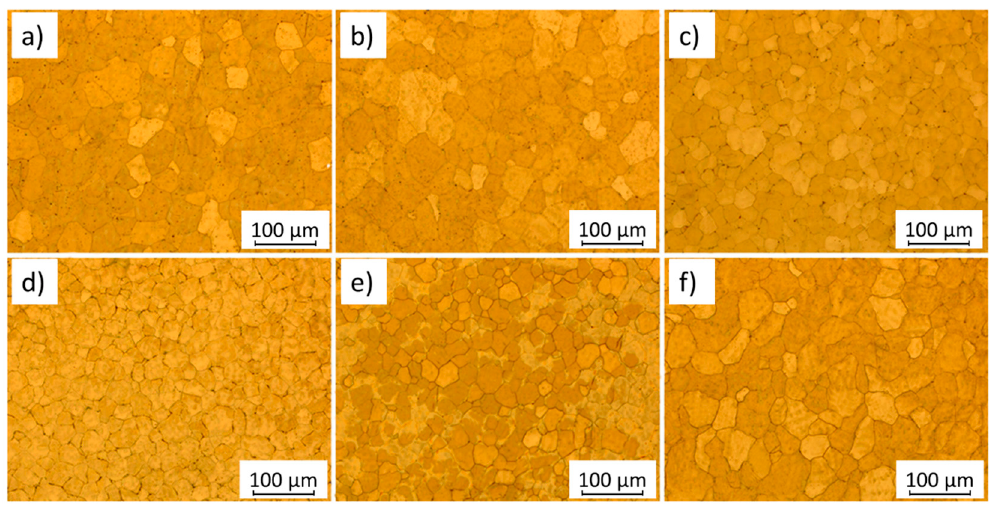
Figure 17. Microstructure of samples produced with a frequency of ( a ) 500 Hz, ( b ) 100 Hz, ( c ) 10 Hz, ( d ) 5 Hz, ( e ) 2 Hz, and ( f ) 1 Hz (adapted from [88]).